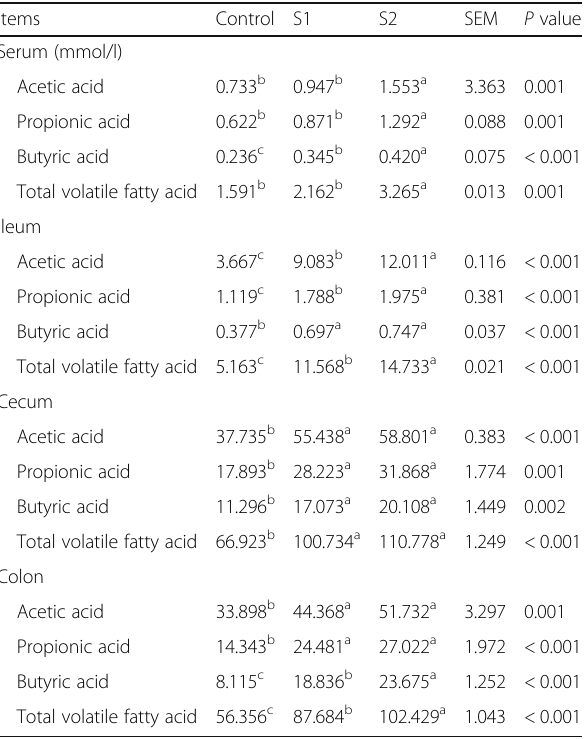
Table 1 Effect of gastric infusion of SCFA on SCFA concentration in ileal, cecal, colonic digesta, and serum of weaned piglets ( μ mol/g)